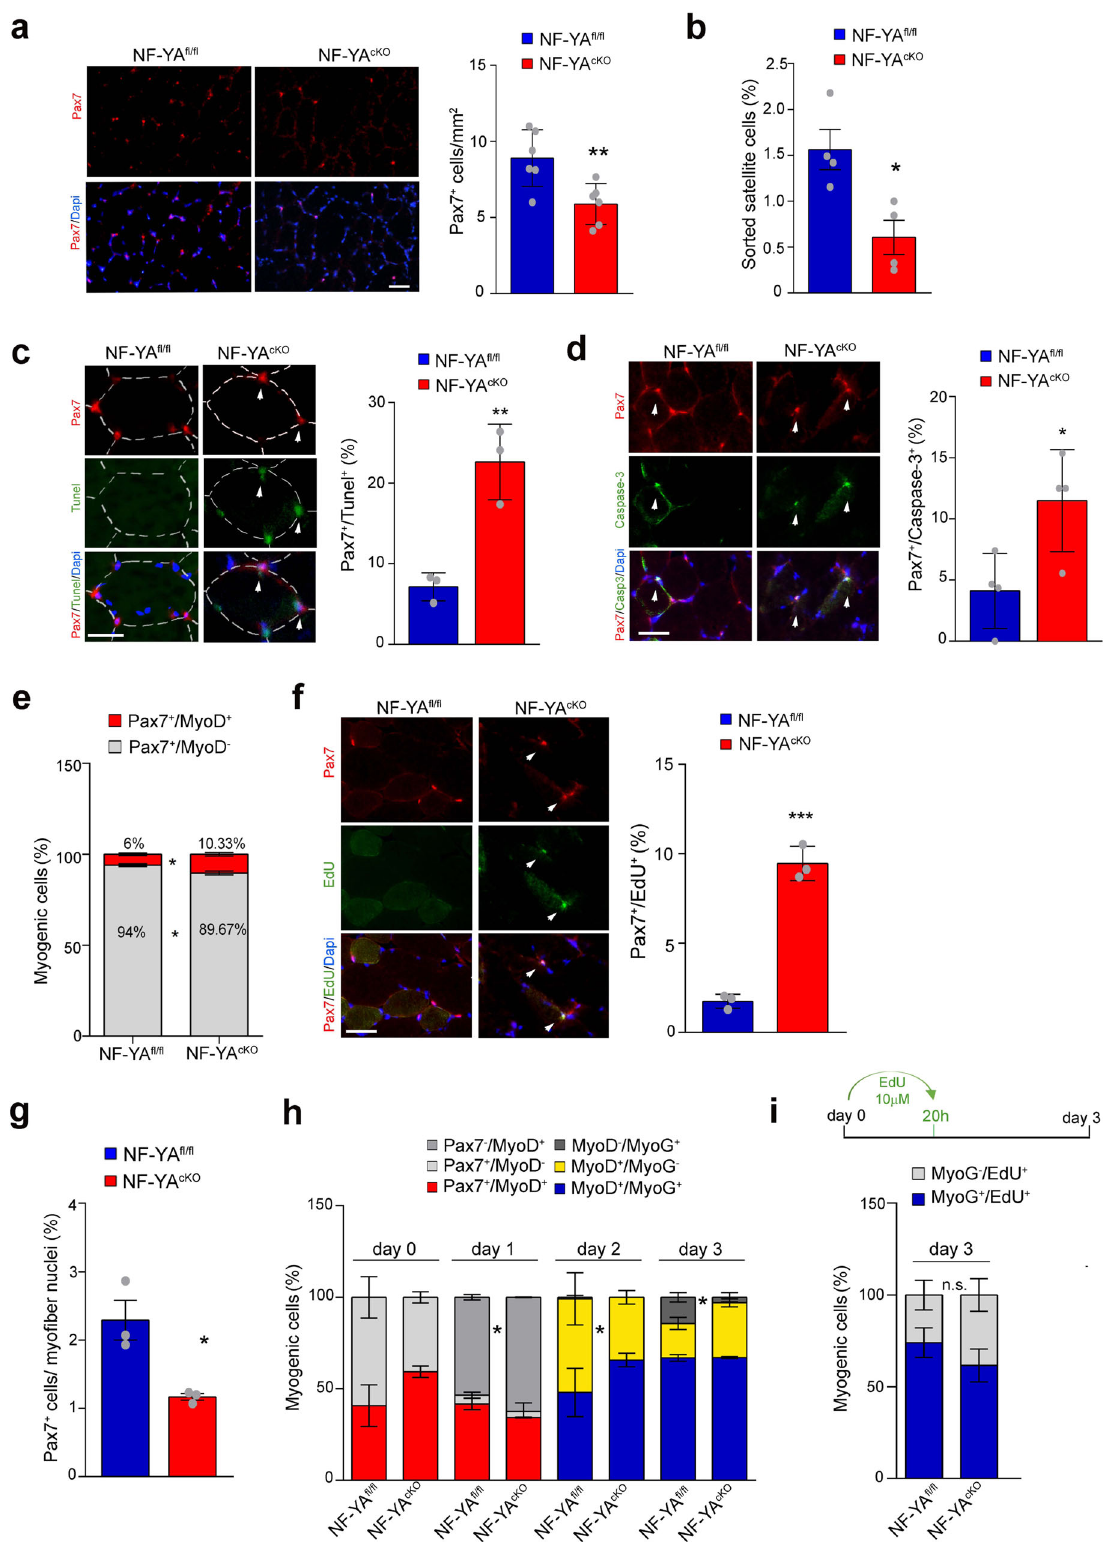
shown in other conditional NF-YA knock-out mouse models because of the negative transcriptional feedback existing between NF-Y subunits 24 – 26 (Supplementary Fig. 3b). The effects of NF- YA KO on the expression levels of p57, Myogenin and NF-YB were con fi rmed by western blot on total SCs extracts (Supple- mentary Fig.